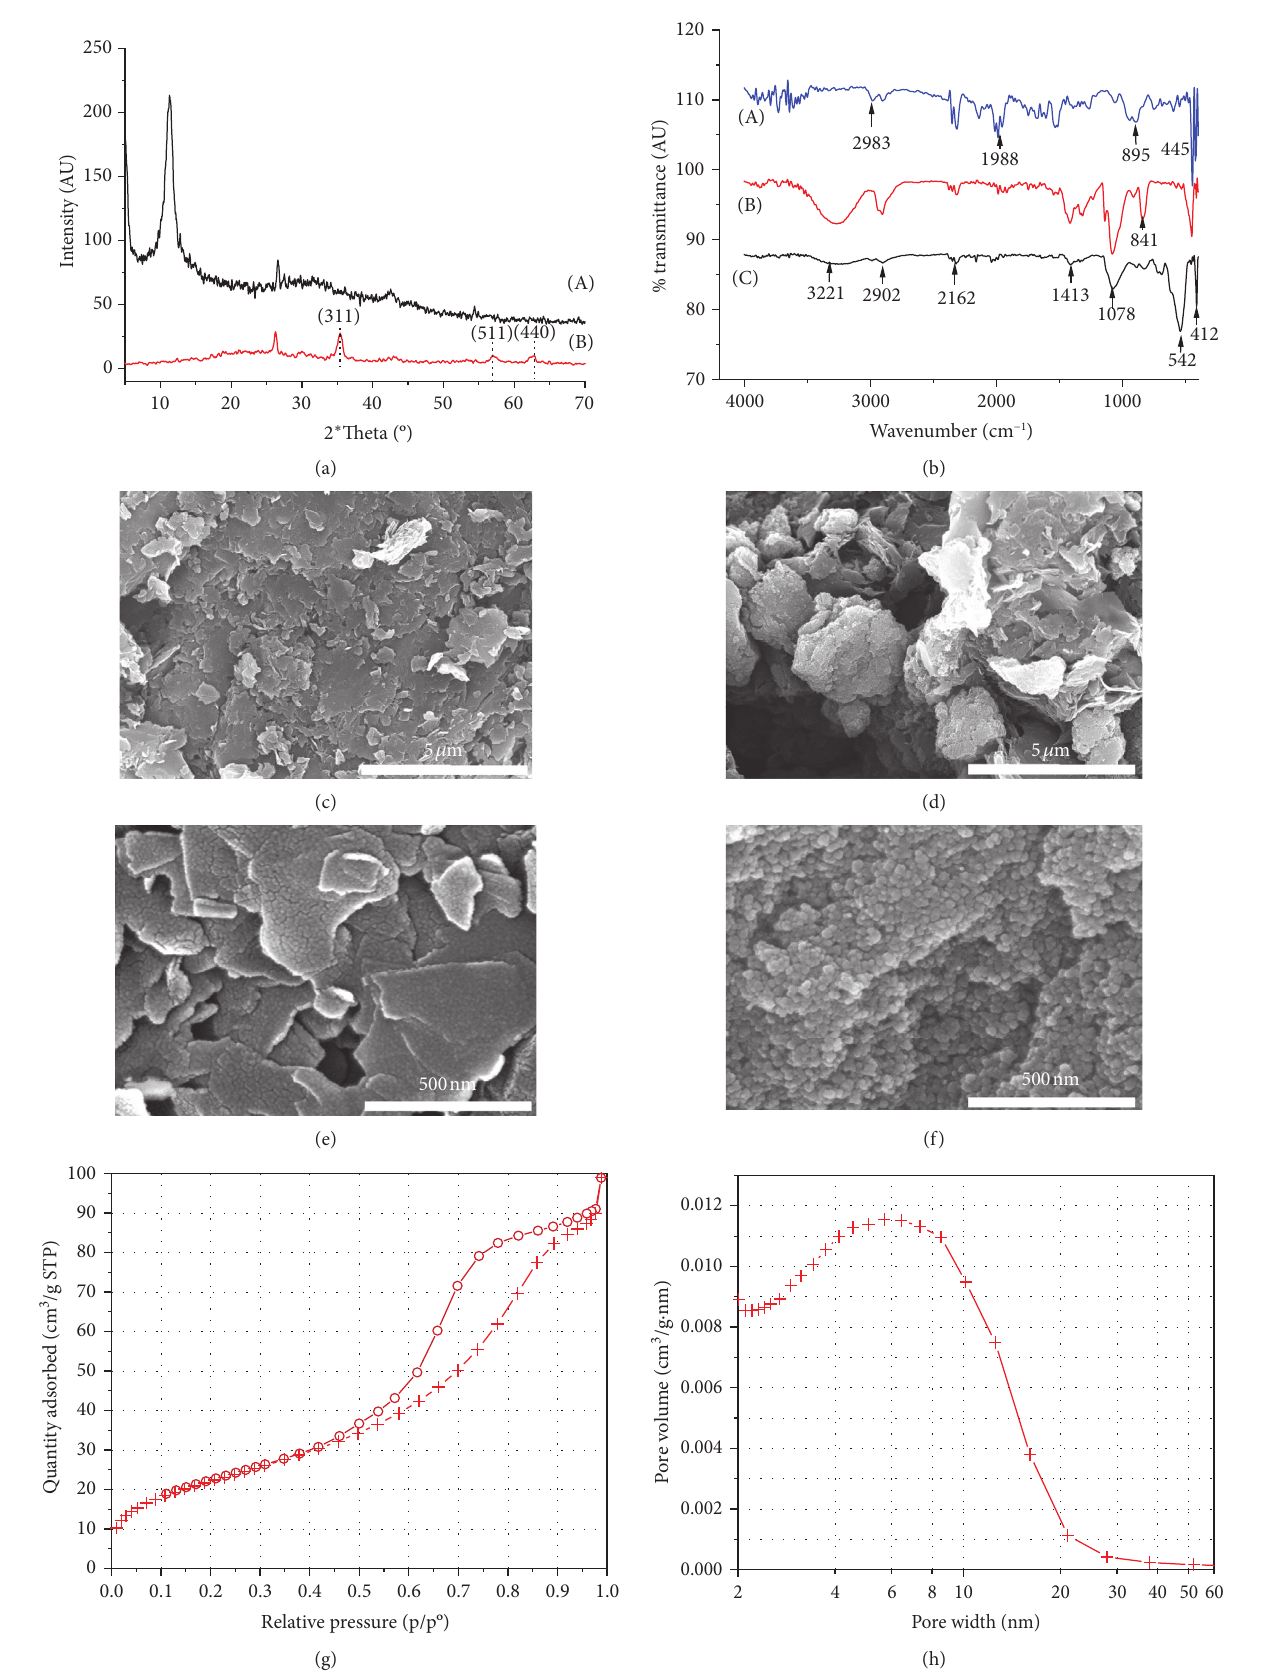
Figure 1: (a) XRD patterns of GO (A) and GO/PVA/Fe 3 O 4 (B) sample; (b) FT-IR of GO (A), PVA (B), and GO/PVA/Fe 3 O 4 (C); (c–f) SEM images with different magnifications of (c, e) GO and (d, f) GO/PVA/Fe 3 O 4 , respectively; nitrogen (N 2 ) adsorption-desorption isotherm (g) and BJH pore size distribution (h) of the as-synthesized GO/PVA/Fe 3 O 4